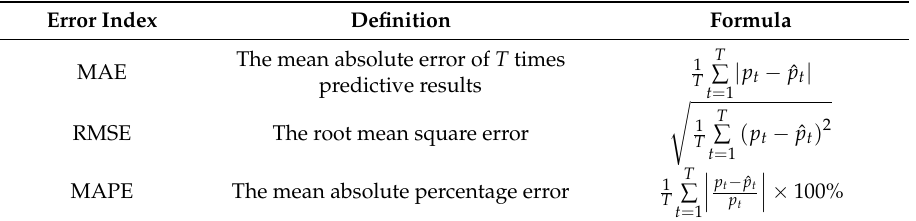
Table 4. The metric equations.